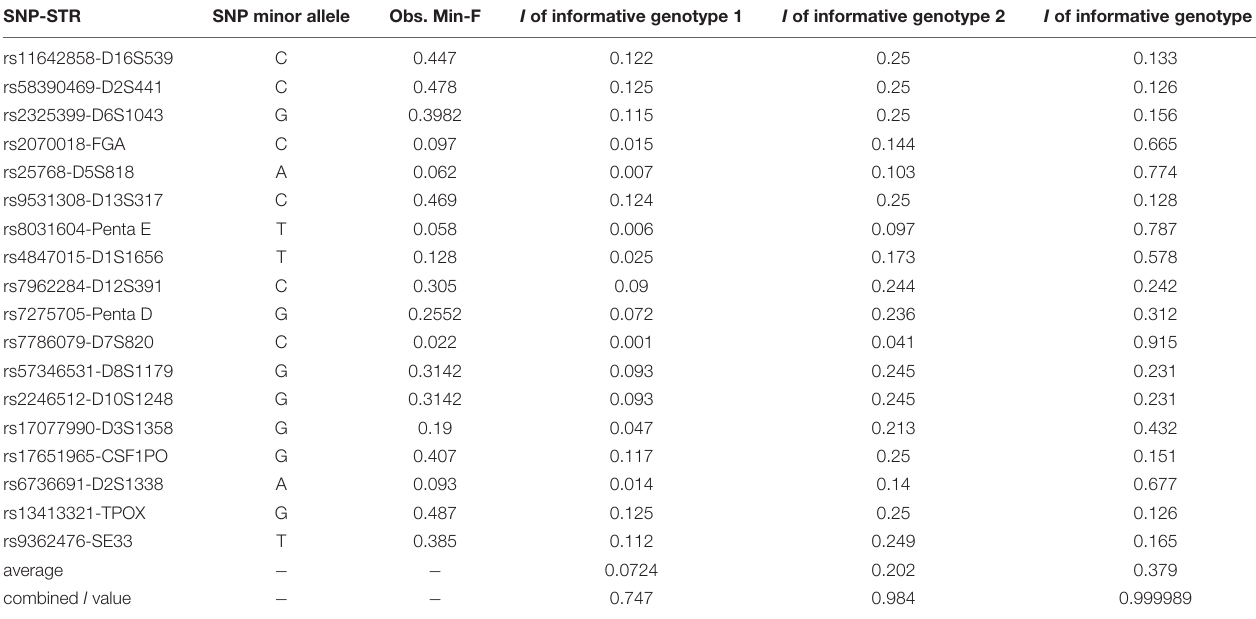
Supplementary Table 1 . The SNP-STR profiles of 9948-control DNA are shown in Figure 4 . Panel-A and Panel-B were composed of 12 identical SNP-STR loci with different allele-specific primers. Panel-C contained the remaining six